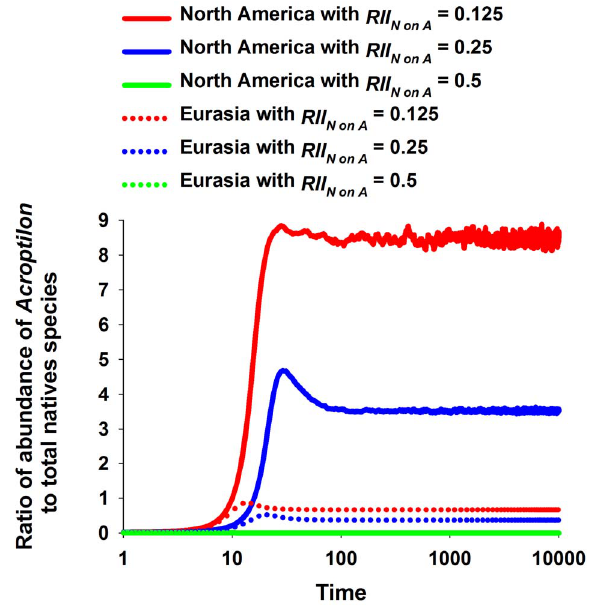
Figure 1. Ratios of abundances of Acroptilon to total native species in different competitive scenarios. In all scenarios the competitive effects of Acroptilon were derived from experiments reported in Ni et al. (2010). For scenarios for the native and non-native ranges the mean competitive effects of native species on Acroptilon were varied from RII=0.125 to RII=0.500. Scenarios for the North American range are represented by solid lines and Eurasian scenarios are represented by dashed lines. Note the log scale for the x-axis.